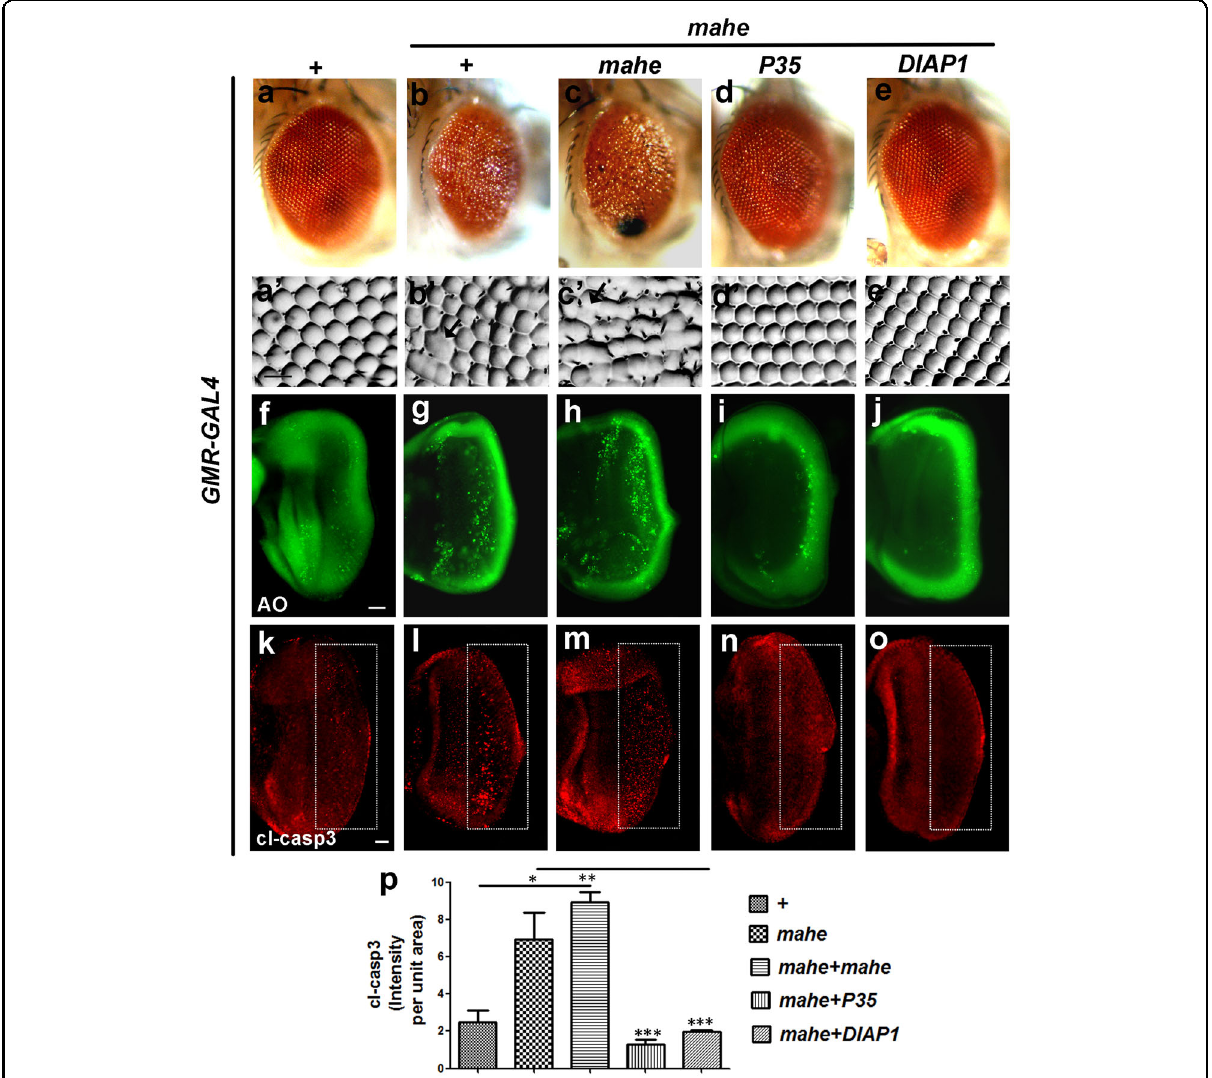
Fig. 2 Ectopic expression of mahe promotes caspase-dependent dosage sensitive cell death in eye tissue of Drosophila . a – e Images of Drosophila adult eyes. a ′ – e ′ Eye imprints of adult eye. GMR-GAL4 was used as a control ( a ), or to drive expression of mahe ( b – e ), P35 ( d ), DIAP1 ( e ). a , a